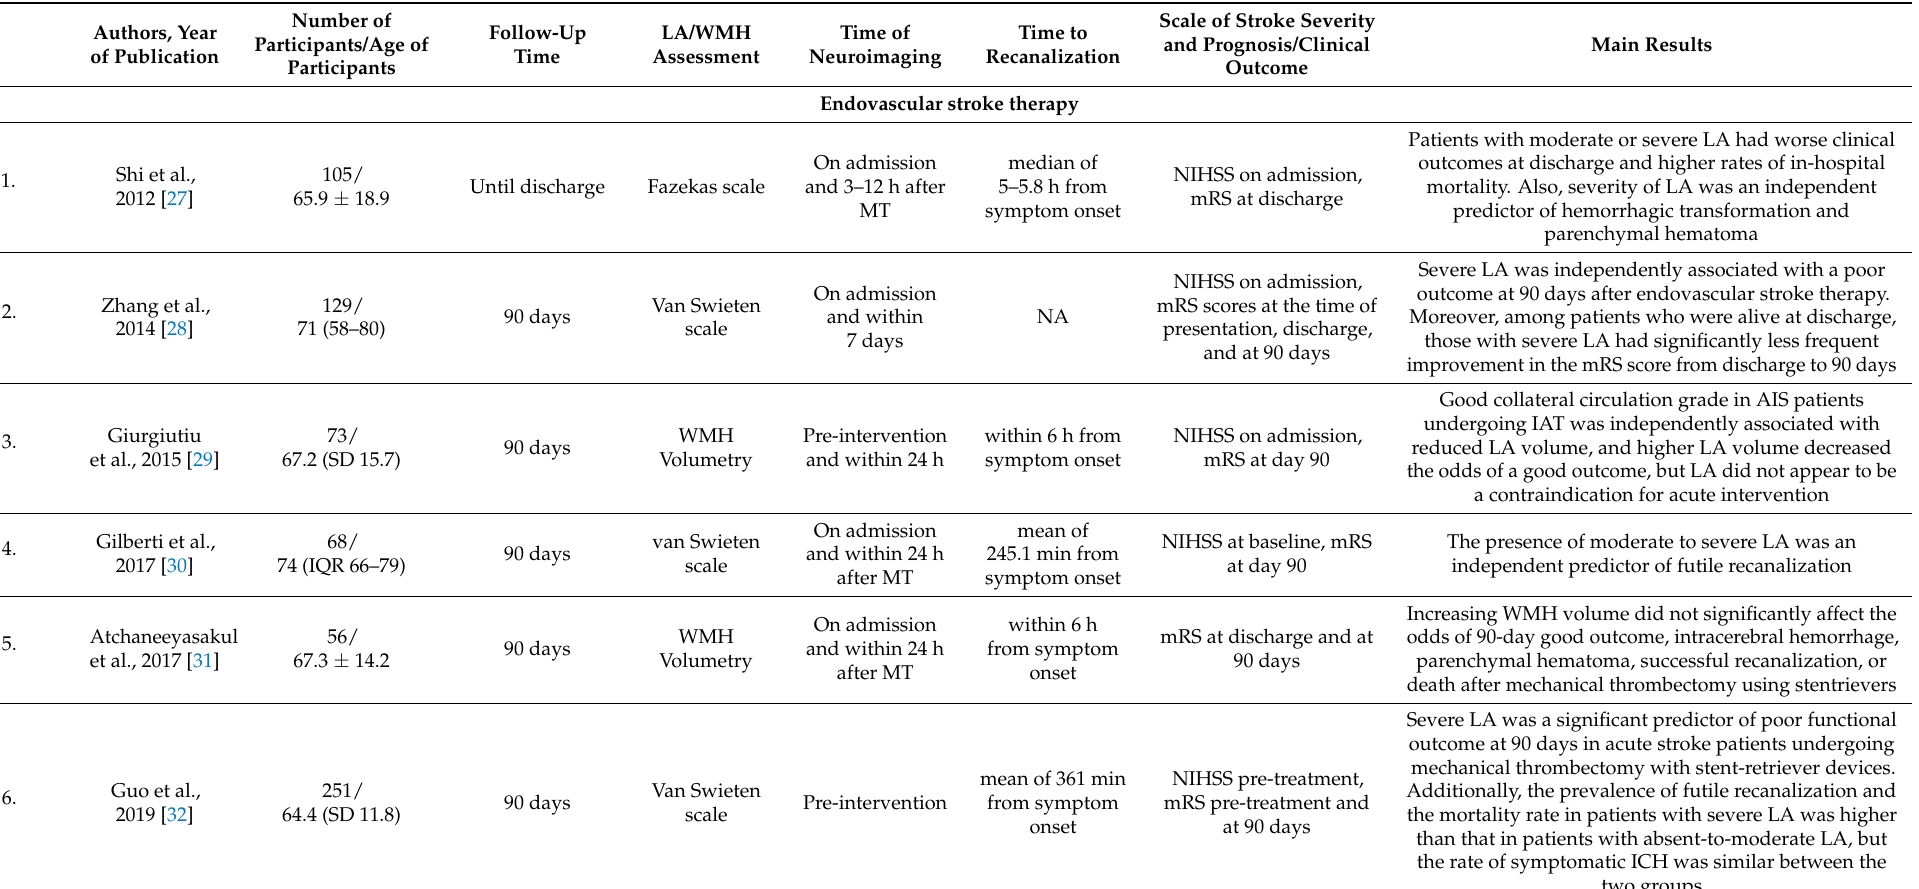
Table 1. Characteristics of the 37 included